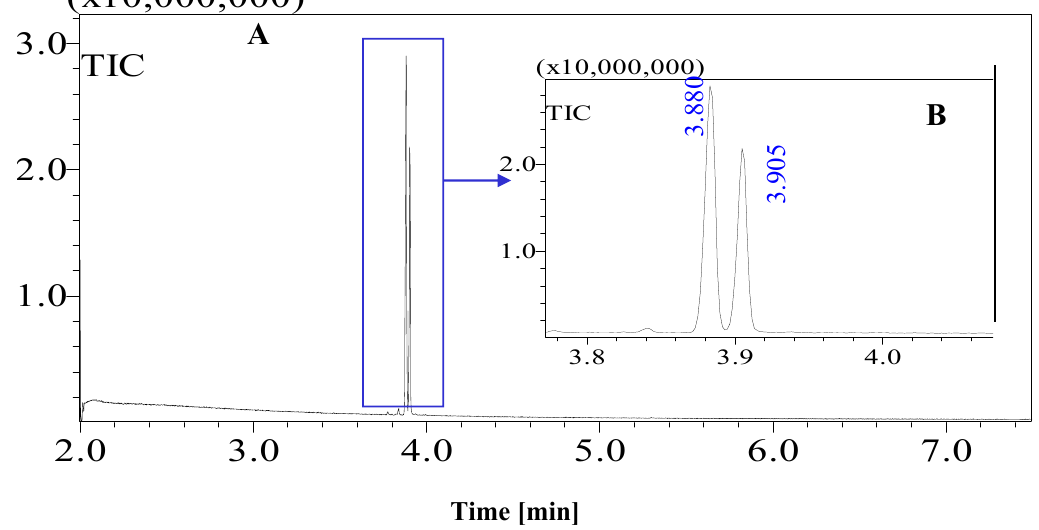
Figure 2. Total ion chromatogram (TIC) of standard fructose. A fructose sample was oximated and silylated. Syn and anti-forms of fructose were observed at 3.88 and 3.905 min, respectively. ( A ) Whole chromatogram of standard fructose for a 7-min measurement; ( B ) the fructose chromatogram from 3.8–4.0 min.